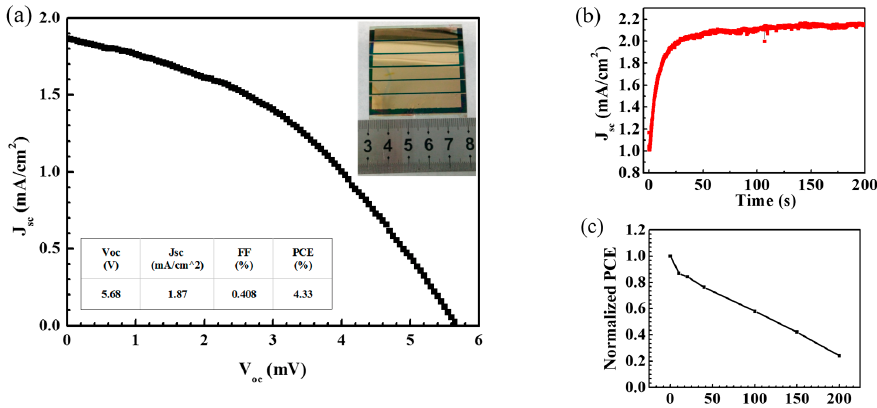
Figure 9. ( a ) J-V characteristics of a typical flexible PSC of 5 cm × 5 cm with an active area of 13.5 cm 2 , tested without a mask. Inset photograph is the typical flexible PSC. ( b ) Photocurrent density measured as a function of time for the same flexible PSC held at 2.5 V forward bias. ( c ) Normalized PCE of the large-area flexible PSC after bending tests using 50 mm radii of curvature.